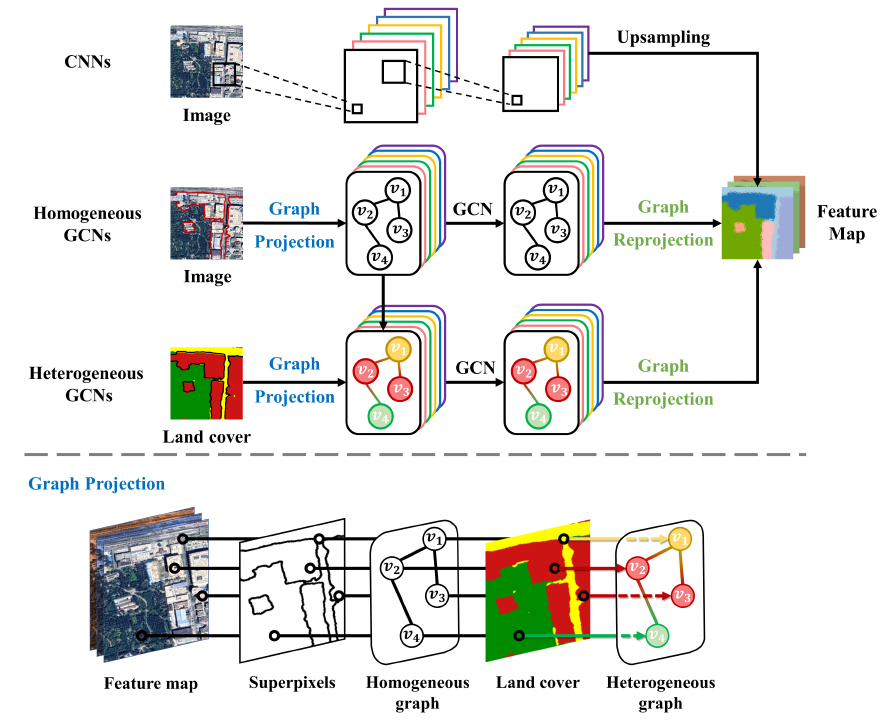
Figure 1. Comparison of CNNs, homogeneous GCNs, and heterogeneous GCNs in feature extrac- tion. The CNNs employ convolutions and pooling on regular regions to obtain feature maps and upsample them to the pixel level. Homogeneous GCNs first transform images into graphs by graph projection, and then apply GCN to obtain node-level features, and finally produce pixel-level feature maps by graph re-projection. Heterogeneous graphs differ from homogeneous graphs in the graph construction. Nodes of heterogeneous graphs are labeled with land cover classes in graph projection. Edge weights are determined by the corresponding node pair’s class. Graph projection is described in detail at the bottom, and graph reprojection is the inverse process of